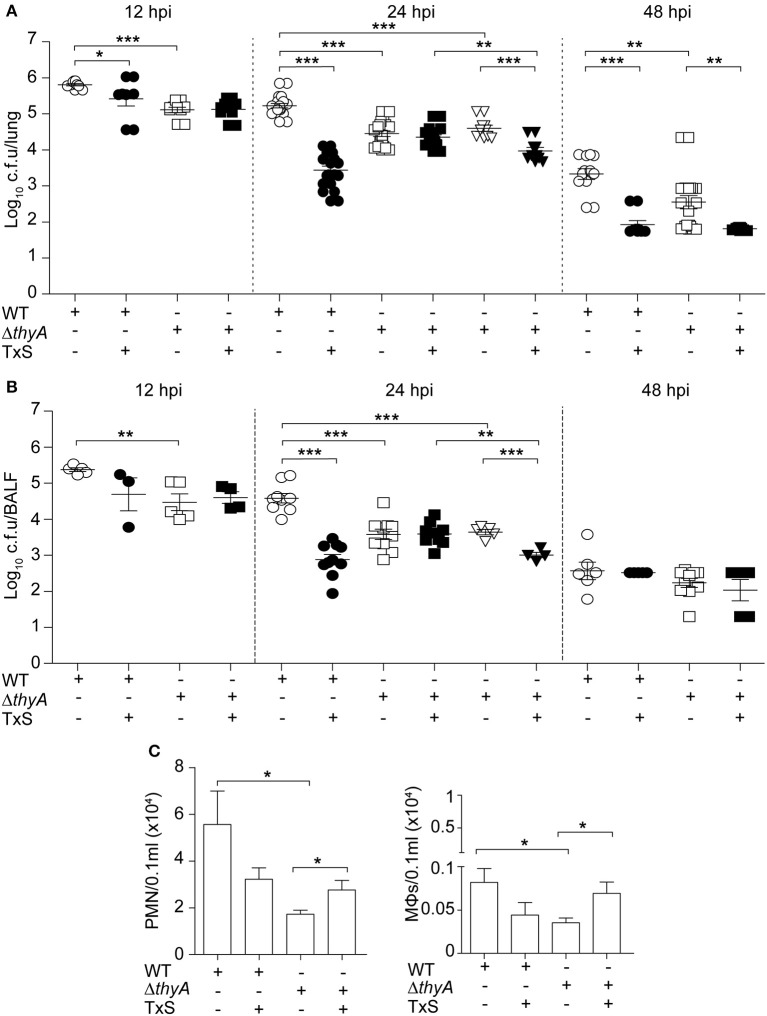
Inactivation of the thyA gene attenuates H. influenzae virulence and confers advantage under TxS treatment in vivo. CD1 mice were infected with ~2 × 107 bacteria/mouse of NTHi375 WT (circle) or ΔthyA (square) strains. When necessary, a therapeutic regimen consisting of 960 mg/kg TxS (1:5 TMP:SMX) was administered orally each 6 h (dark symbols). Mice were euthanized at 12, 24, and 48 hpi, and bacterial loads were quantified in lungs (log10 c.f.u./lung) (A) and BALF (log10 c.f.u./BALF) (B). NTHi375ΔthyA showed significantly lower loads in lungs and BALFs at 12 (lung, p < 0.001; BALF, p < 0.01), 24 (lung, p < 0.001; BALF, p < 0.001), and 48 (lung, p < 0.01) hpi than those shown by the WT strain. TxS administration significantly reduced WT strain recovery from lungs and BALF samples at 12 (lung, p < 0.05), 24 (lung, p < 0.001; BALF, p < 0.001), and 48 (lung, p < 0.001) hpi, compared to WT infected untreated mice. Inverted triangles: CD1 mice were infected with ~2 × 107 bacteria/mouse of ΔthyA strain previously grown on chocolate+Thy for 16 h; when necessary, a therapeutic regime consisting of 960 mg/kg TxS was administered orally each 6 h (dark inverted triangles). NTHi375ΔthyA previously grown on chocolate+Thy rendered significantly lower loads in lungs and BALFs than the WT strain (p < 0.001); NTHi375ΔthyA previously grown on chocolate+Thy showed significantly lower loads in lungs and BALFs of TxS treated—than in those of untreated mice (p < 0.001); in TxS treated mice, NTHi375ΔthyA previously grown on chocolate+Thy showed lower loads in lungs and BALFs than NTHi375ΔthyA previously grown on chocolate agar (p < 0.01). (C) BALF samples were analyzed for PMN (left) and alveolar macrophage (MΦ; right) counts at 12 hpi. Significantly higher numbers were observed in NTHi375 WT than in ΔthyA infected samples for both PMN (p < 0.05) and MΦs (p < 0.05). *p < 0.05, **p < 0.01, ***p < 0.001.